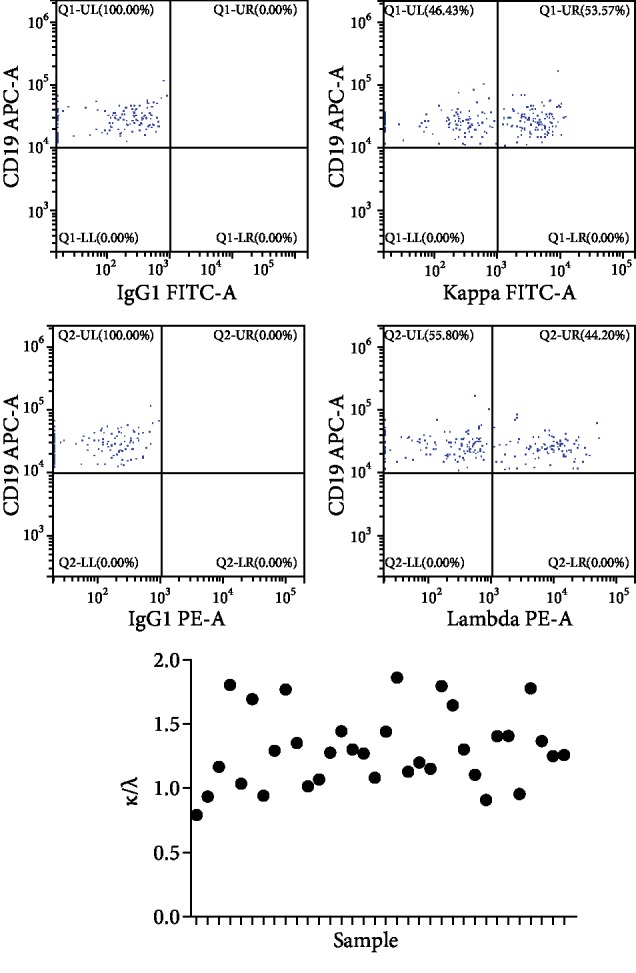
Kappa : lambda ratios (κ/λ) for B lymphocytes in IRP patients. No ratios were >3 : 1 or <1 : 3.